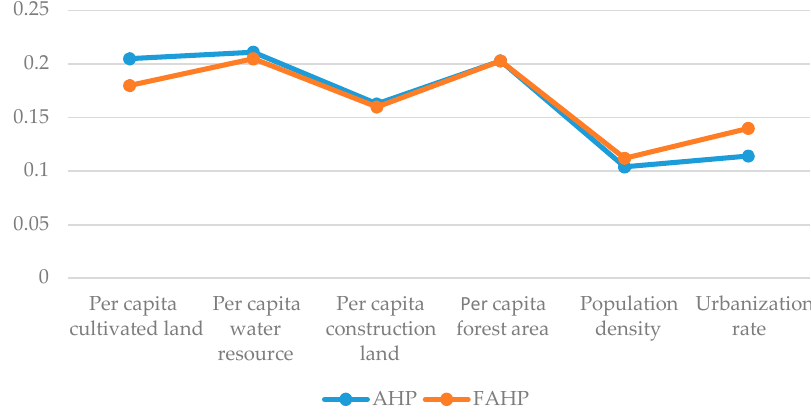
Figure 3. Sensitivity analysis of the AHP results .